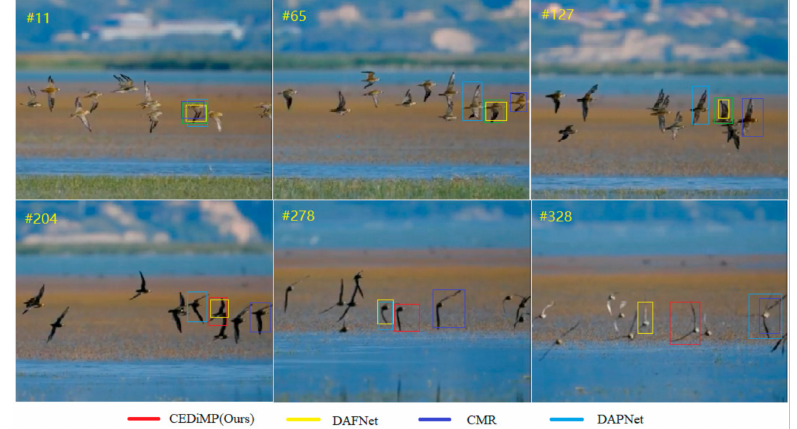
Figure 10. Qualitative comparison results of single RGB modality.